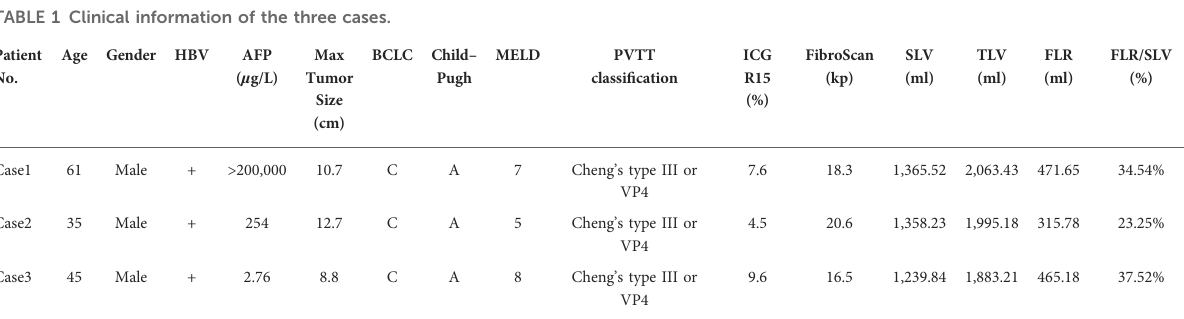
TABLE 1 Clinical information of the three